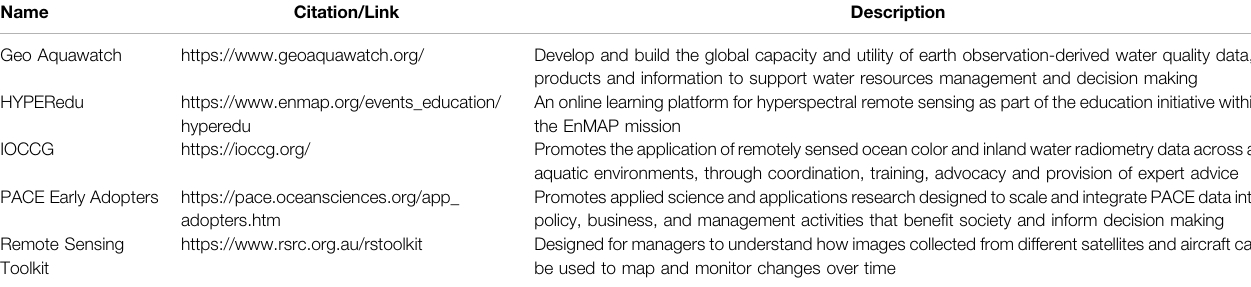
TABLE 5 | Relevant outreach programs. Name Citation/Link